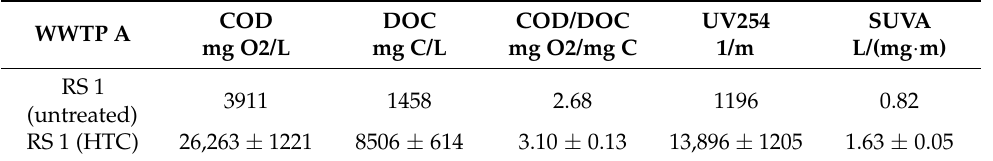
Table 4. Sum parameters to characterize the organic load of the untreated liquid phase and the hydrothermally treated liquid phase (mean value ± standard errors of n =